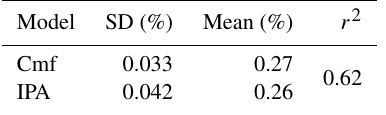
Table 6. Statistical parameters from model comparison between cmf and IPA with kernel-based weight